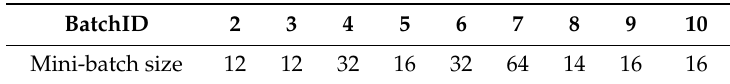
Table 3. Corresponding Parameter Setting (mini-batch size) of the WDLFR under Experimental Setting